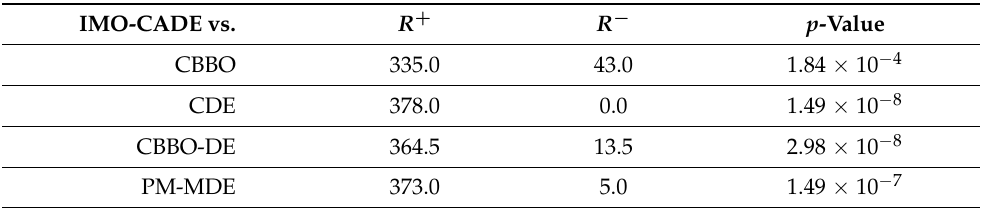
Table 6. Results obtained by the Wilcoxon test for IMO-CADE vs. other methods with reported results under correlated